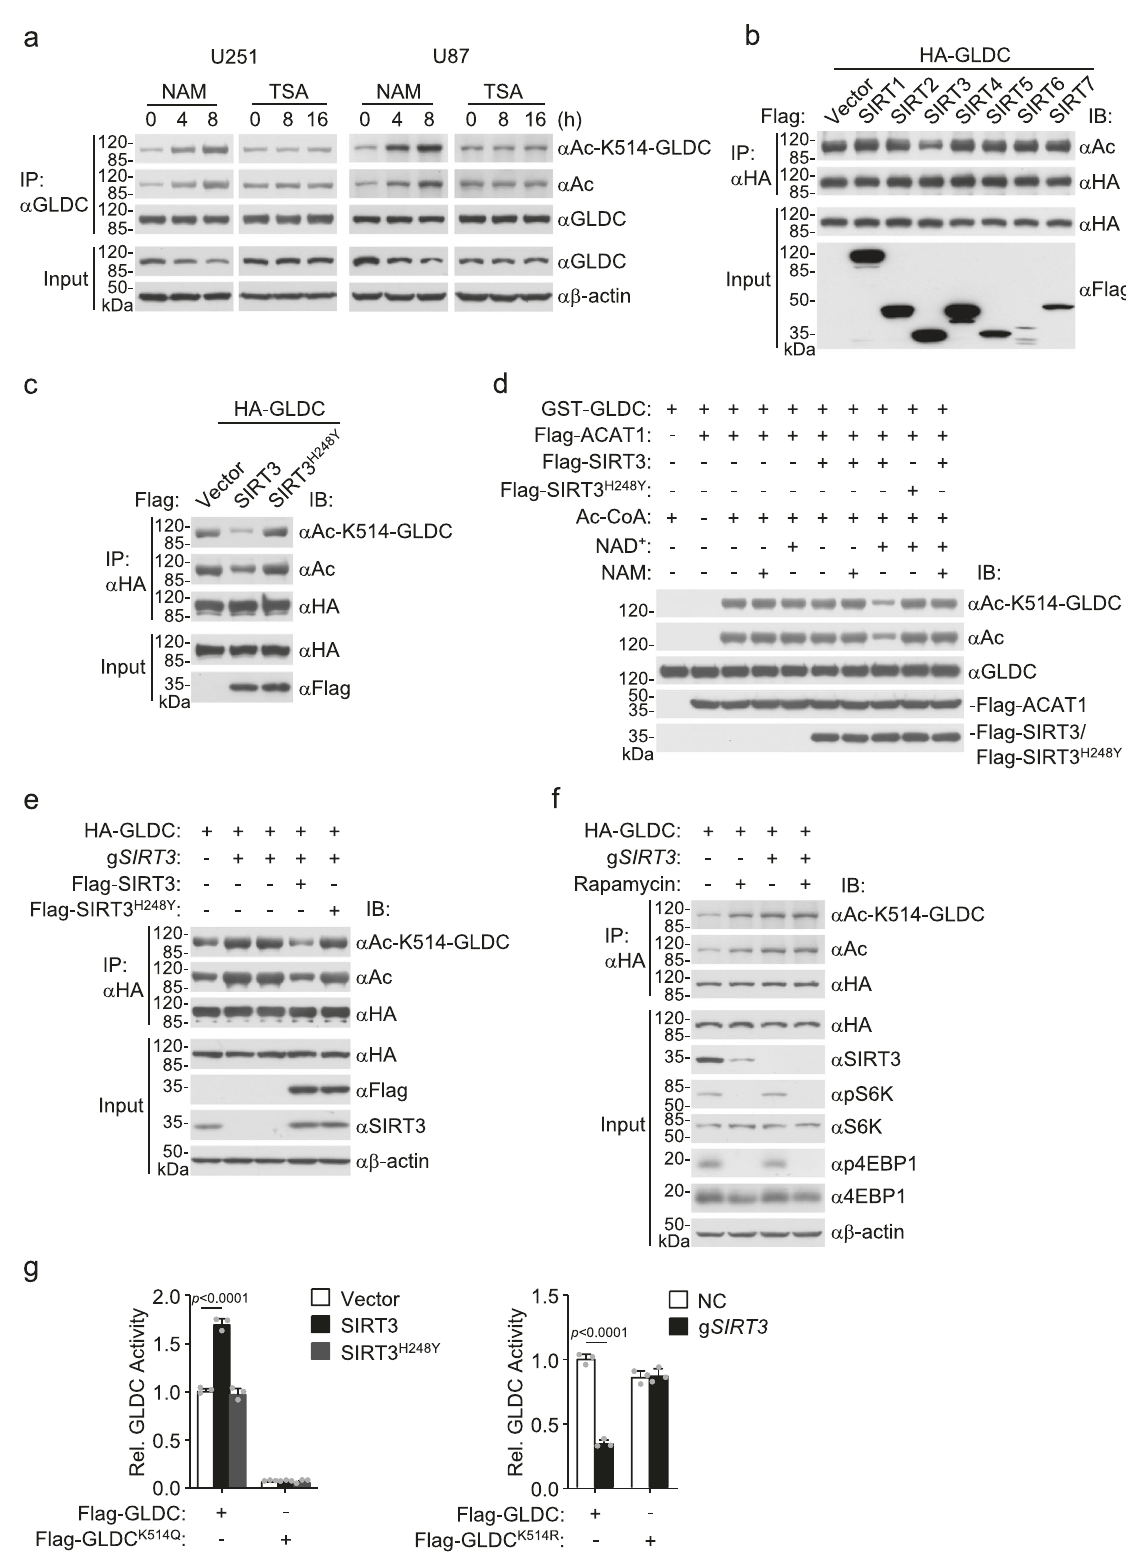
(C358 or C361 mutated to serine) promoted K33-linked poly- ubiquitination of GLDC (Fig. 6c). NF-X1 de fi ciency impaired K33-linked polyubiquitination of GLDC induced by Rapamycin treatment (Fig. 6d). These results suggest that NF-X1 catalyzes K33-linked polyubiquitination of GLDC following its K514 acetylation induced by mTORC1